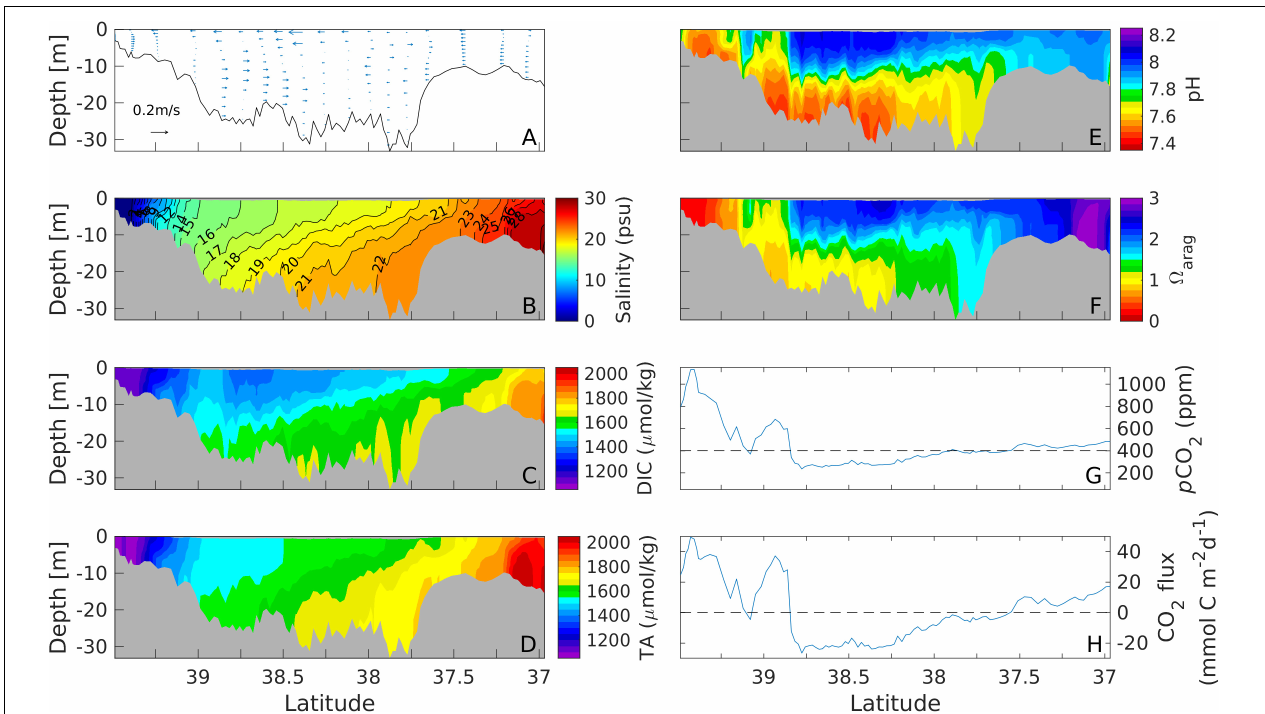
FIGURE 5 | Along channel distributions of subtidal current (A) , salinity (B) , DIC (C) , TA (D) , pH (E) , (cid:127) arag (F) , surface p CO 2 (G) , and air-sea CO 2 flux (H) during an up-estuary wind event on 18–22 September, 2013.